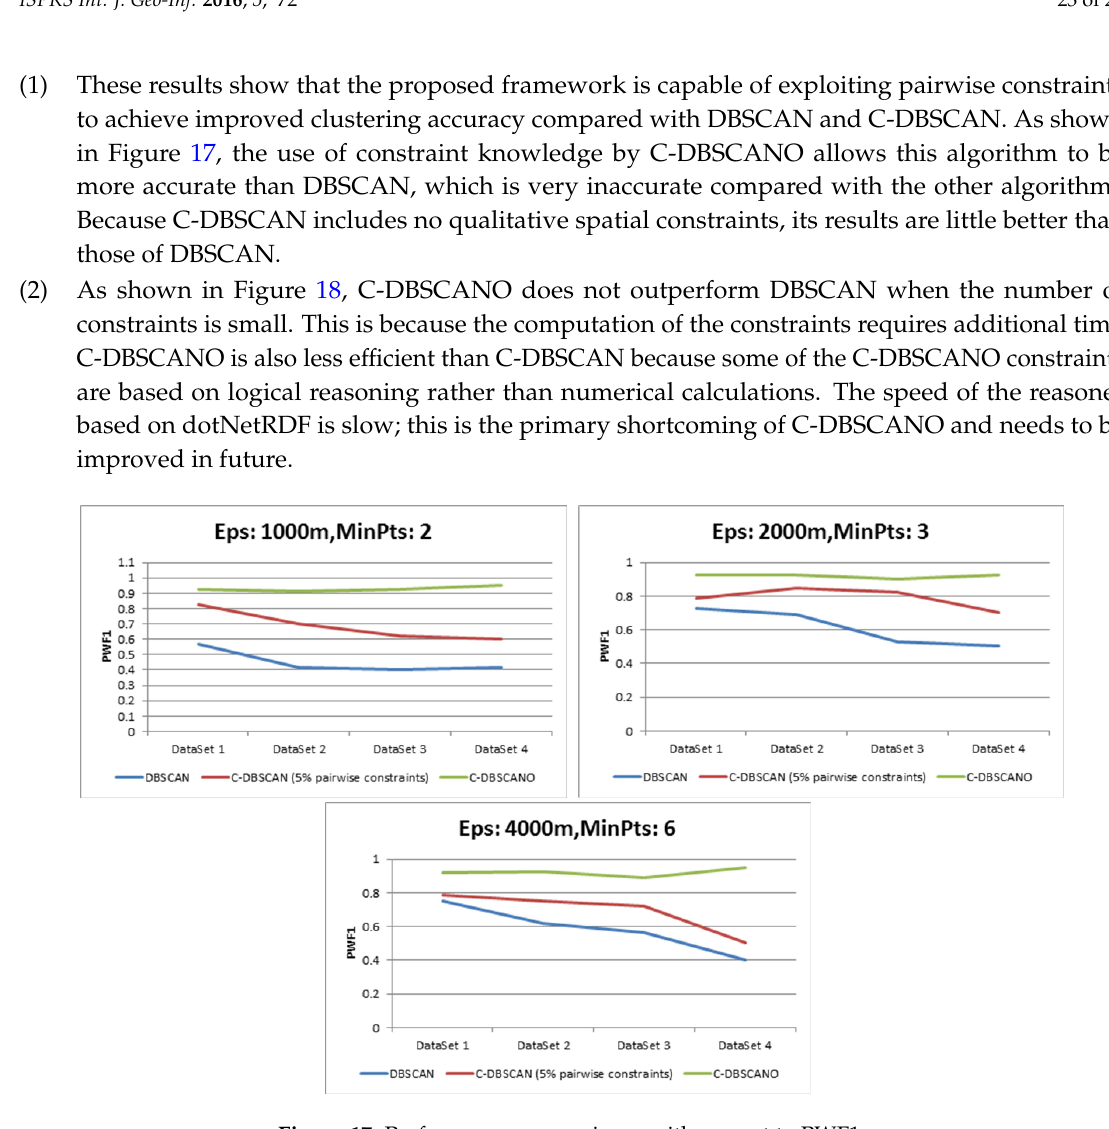
Figure 17. Performance comparisons with respect to PWF1.